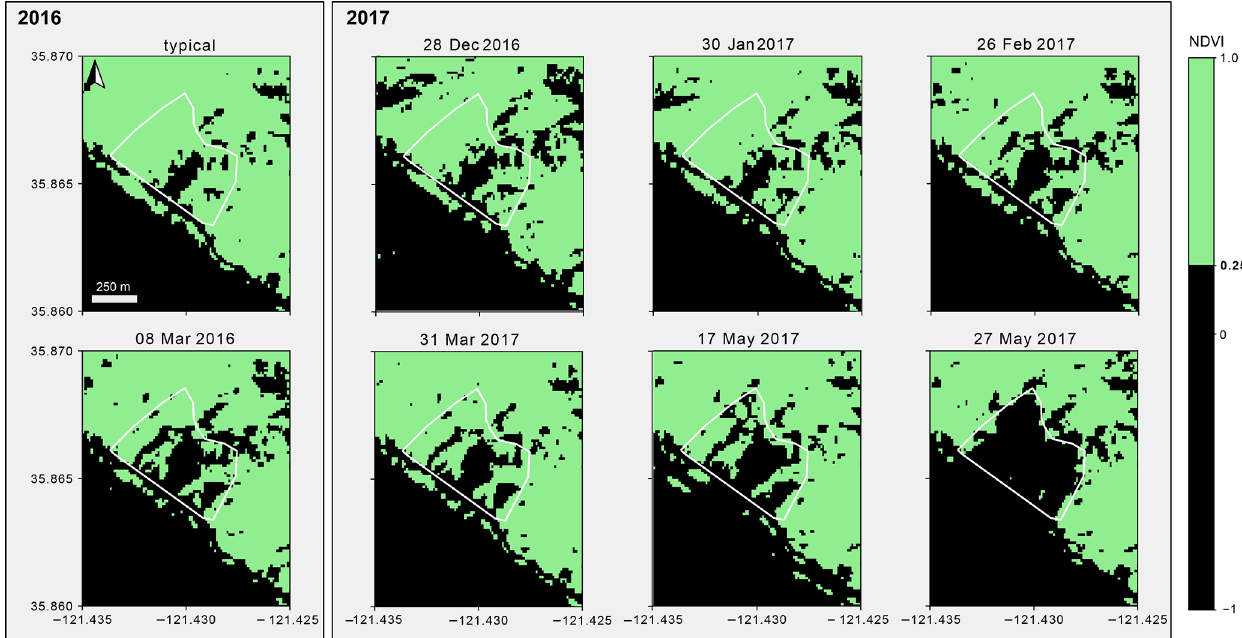
Figure 7. NDVI on the Mud Creek landslide. The first panel shows the pattern that is typical (example from 26 March 2016). The 8 March 2016 panel corresponds to the dip in NDVI ratio visible in early 2016. The area of low NDVI grows ever larger during the spring of 2017, before much of the vegetation is removed during the landslide (post-slide image from 27 May 2017).